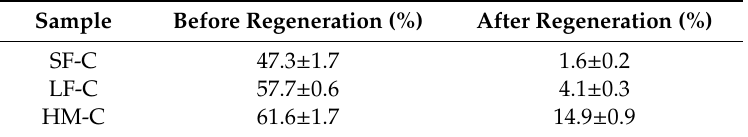
Table 2. Crystallinity of cellulose with di ff erent DPs before and after regeneration. Sample Before Regeneration (%) After Regeneration